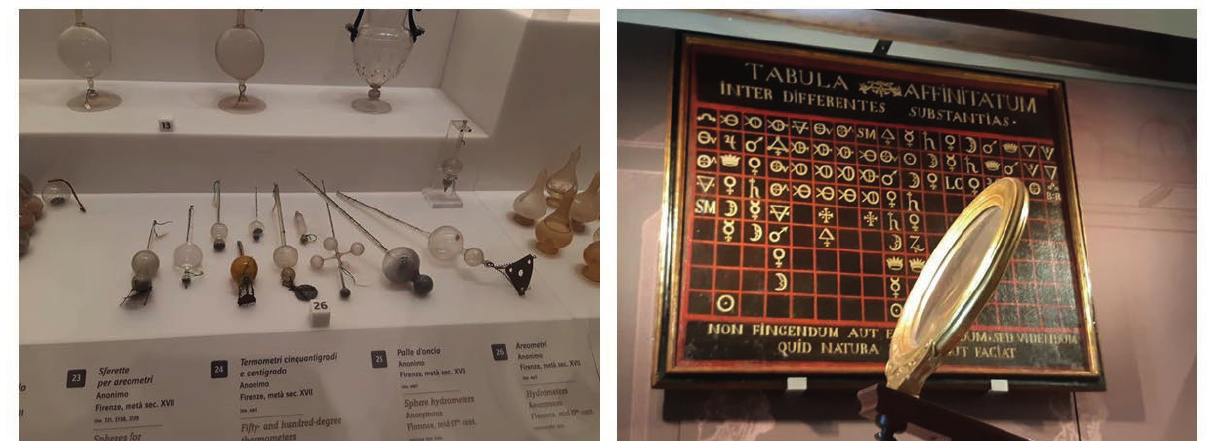
Figure 2. Pictures of historical objects present in the Museum ’Galileo’ related to Chemistry. On the left: collection of thermoscopes and thermometers designed by Ferdinando II de’ Medici in the middle of the XVII century in Florence. On the right: original of the ‘ Tabula affinitatum ’ made by Franz Huber Hoefer in 1766. 56-59 (photo credit: Valentina